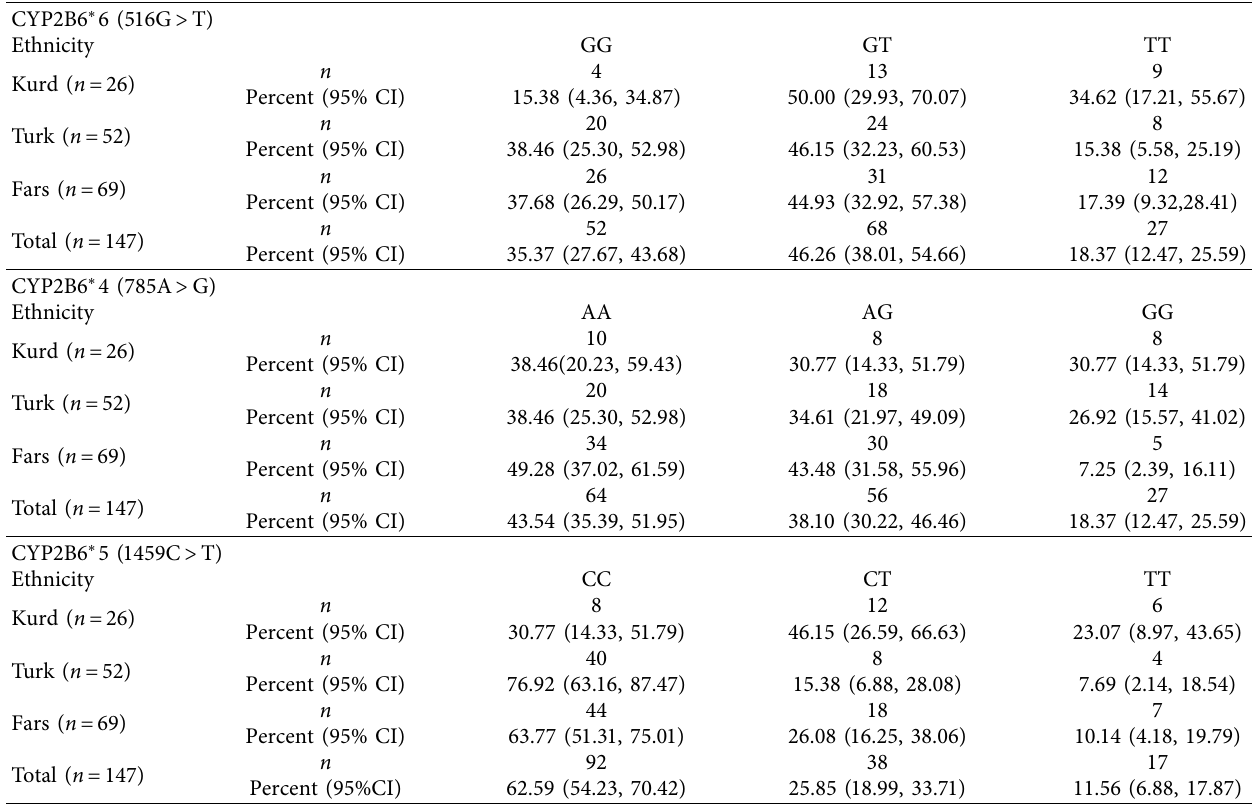
Table 2: Genotype frequencies for CYP2B6 polymorphism in the Kurd, Turk, and Fars population.